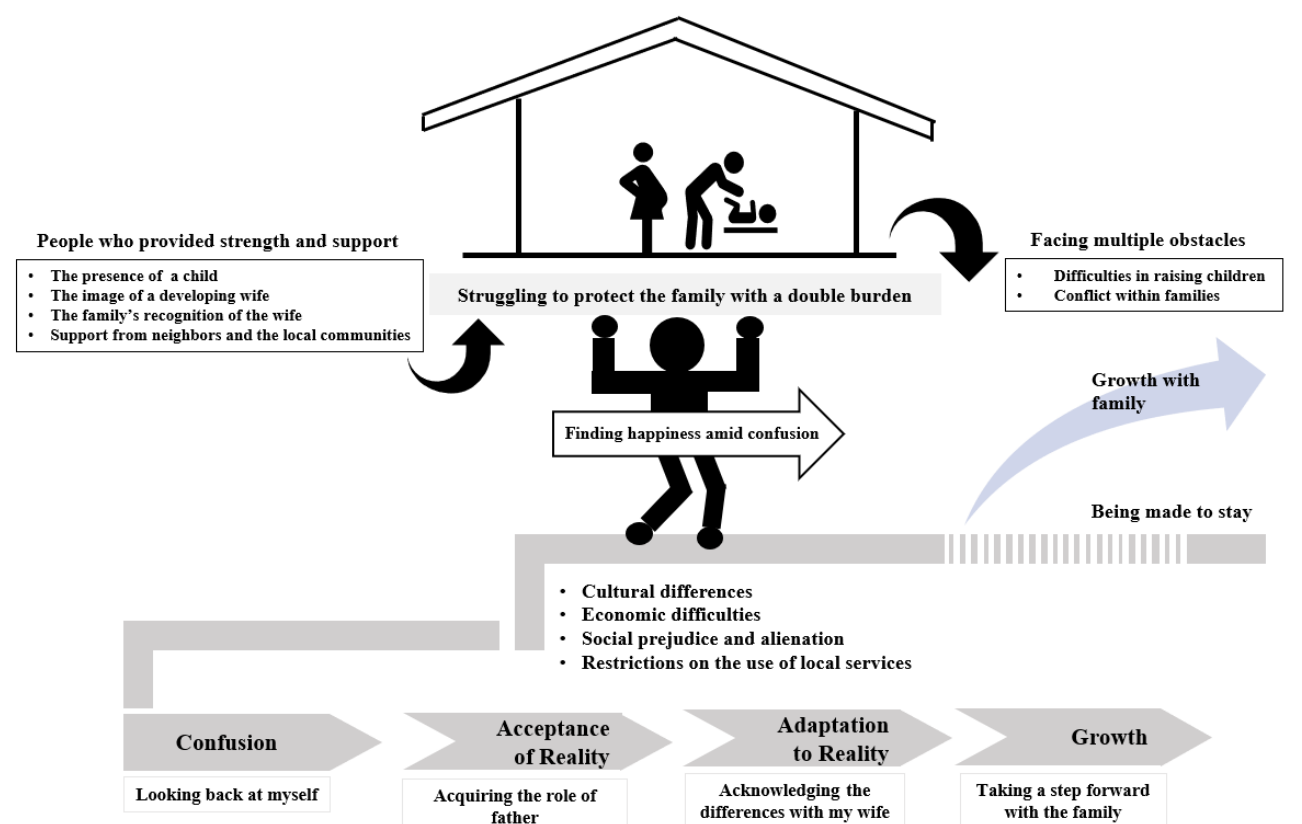
Figure 1. Adaptation process of Korean fathers within multicultural families in Korea .